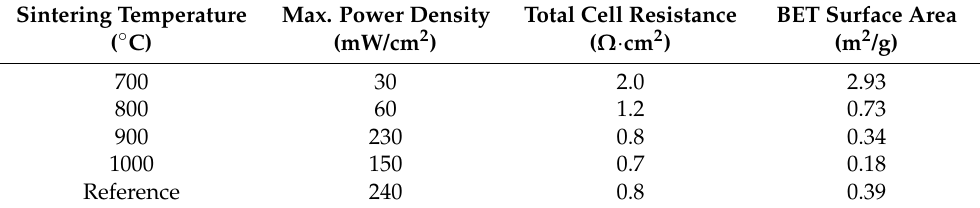
Table 1. The peak power density and the total cell resistance under fuel cell conditions, and the BET surface area of the printed cells and the reference pressed cell.